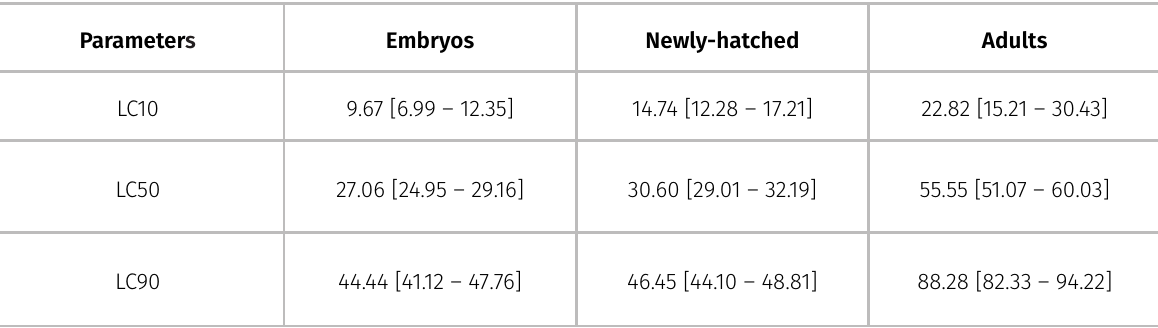
Table I. Lethal concentrations [LC10, LC50 and LC90 (ppm)] of the crude ethanolic extract of the Persea americana stem bark to embryos, newly-hatched and adult of Biomphalaria glabrata . Results represent the mean and confidence interval (95%). (LC50): Mean Lethal Concentration.